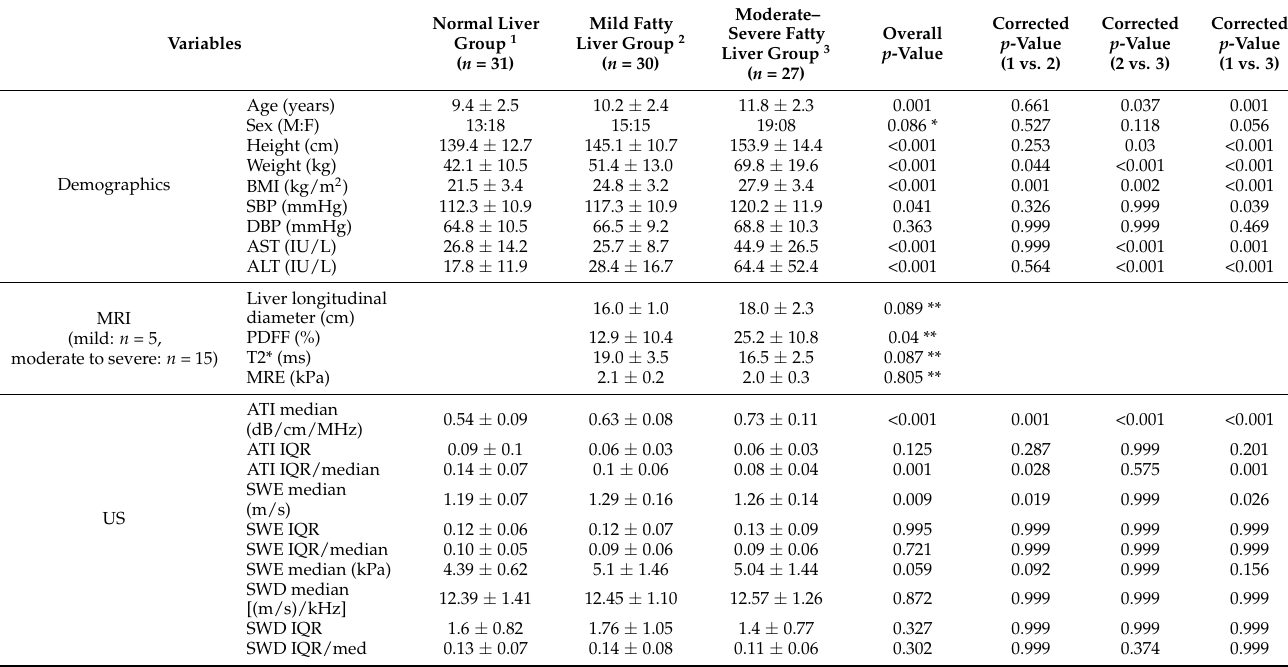
Table 1. Comparison of participant demographics and MRI and US measurements among the three fatty liver groups (normal, mild, and moderate–severe) according to grayscale